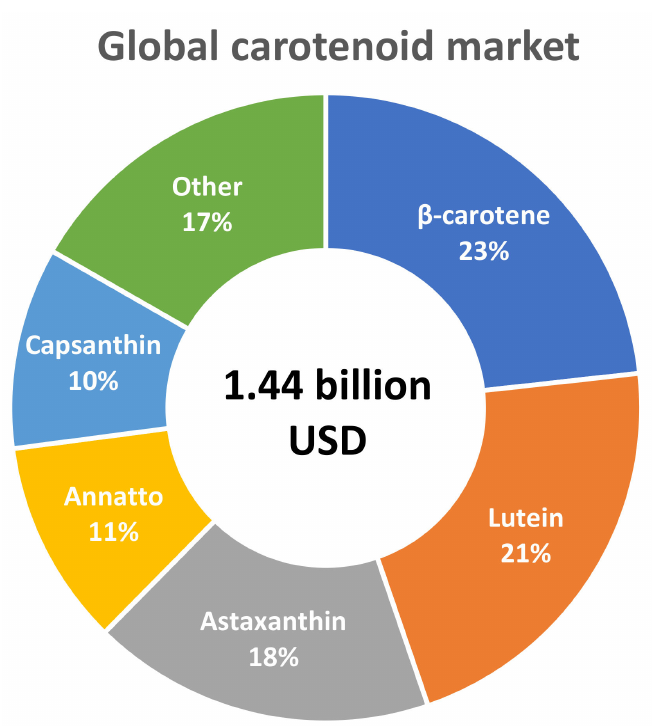
Figure 3. The marketing trends of carotenoids. Source: https://www.bccresearch.com, accessed on 25 February